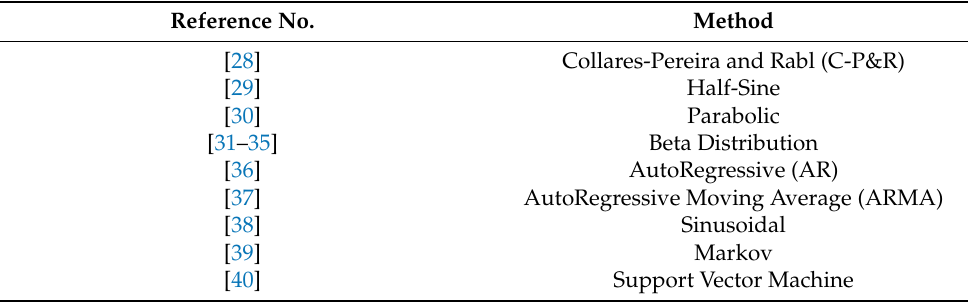
Table 2. Photovoltaic power output